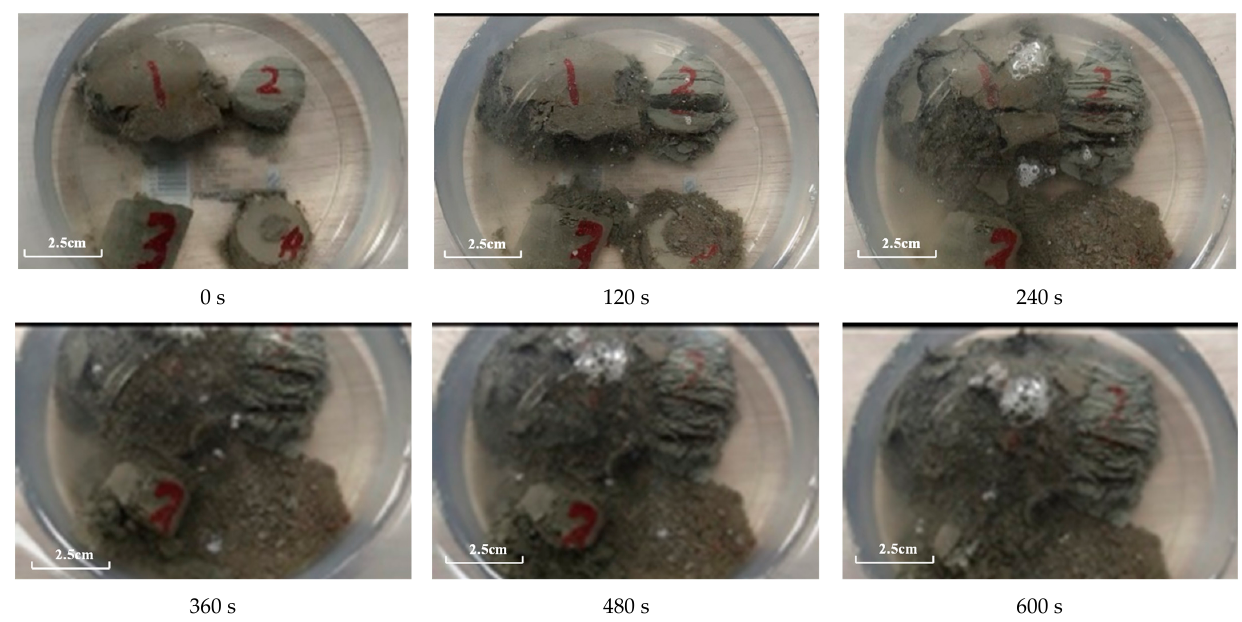
Figure 1. Disintegration process of core samples immersed in the saturated solution of formation water.